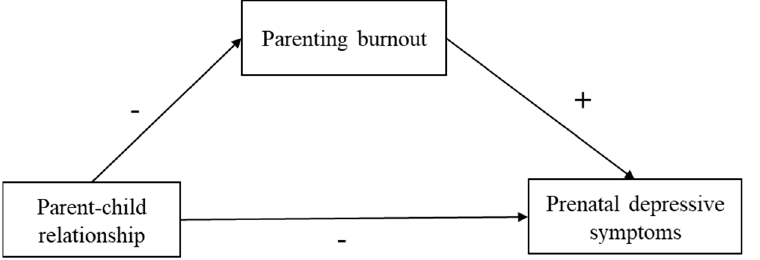
Figure 1. Conceptual Model. Note: “+” means positive forecast, and “ − “ means negative